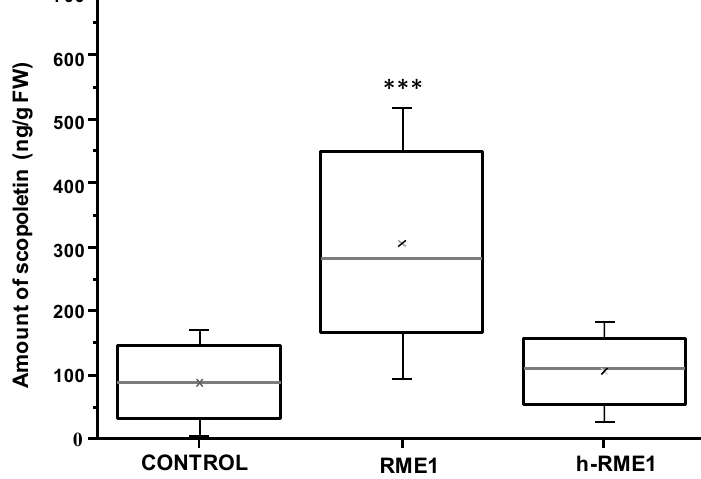
Forests 2020 , 11 , x FOR PEER REVIEW 6 of 14 RME2 infiltration induced similar phenotypic symptoms at 4 dpi on tobacco leaves (Figure 1F,H) but reduced the extent of damage. RME2 did not induce necrotic area at 0.19% PP concentration and the low PP concentration (dilution 16) remained symptomless with no chlorotic zone or fluorescent areas detected suggesting the lower potential of RME2 to induce HR-like reactions. Figure 1. Macroscopic symptoms induced in tobacco leaves by red maple hydroalcoholic (RME1) and water (RME2) infiltrations at 0 dpi, 2 dpi, and 4 dpi observed under bright light ( A , C , E , F ) and UV light ( B , D , G , H ). Tobacco leaves were infiltrated with a range of PP concentrations: 0.19% PP concentration (1) was diluted twice (2), 4 fold (4), 8 fold (8) and 16 fold (16). A-B and C-D represent the same half leaf joined together with UV image reversed horizontally. The E-F and G-H represent the whole leaf infiltrated with RME1 (left) and RME2 (right). Bar 1.5 cm.